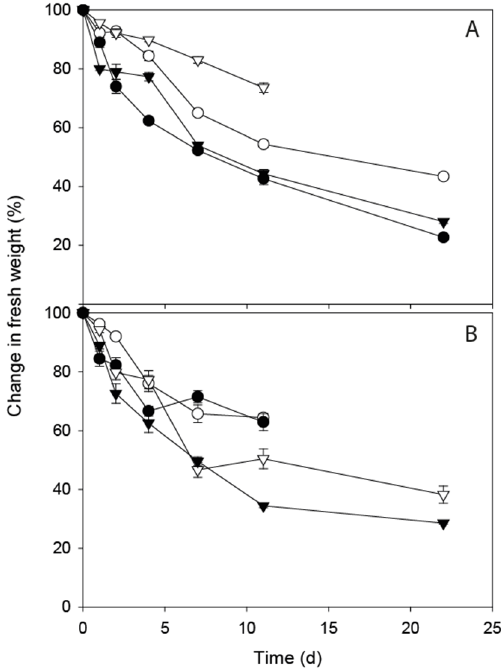
Figure 5. Changes in fresh weight (%) over time dairy faeces ( A ) and deer faeces ( B ) held at: constant 4 °C (solid black circle); −4 °C freeze–thaw (open circles); constant 0 °C (solid triangle); −8 °C freeze–thaw (open triangles). Data points are the mean of five replicates ± standard error.